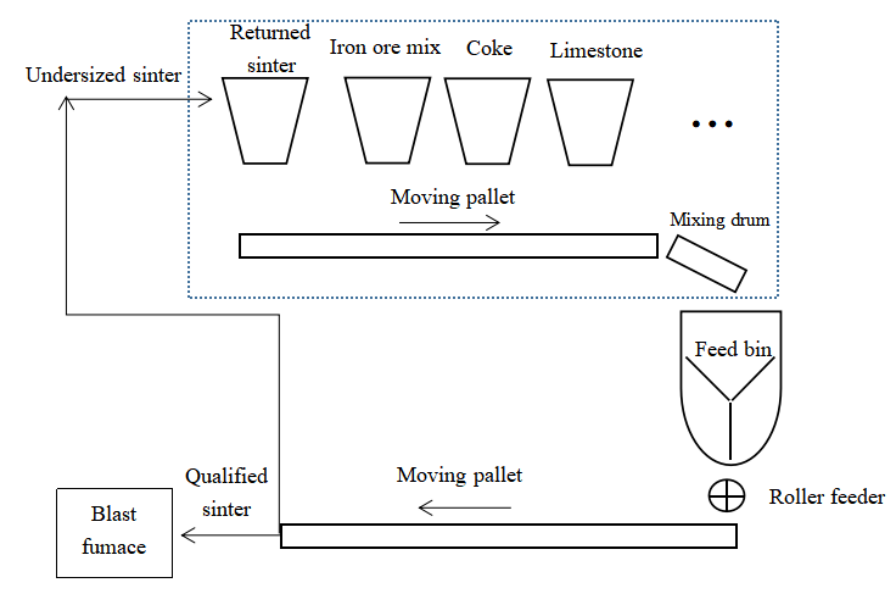
Figure 1. Material flows in the sintering